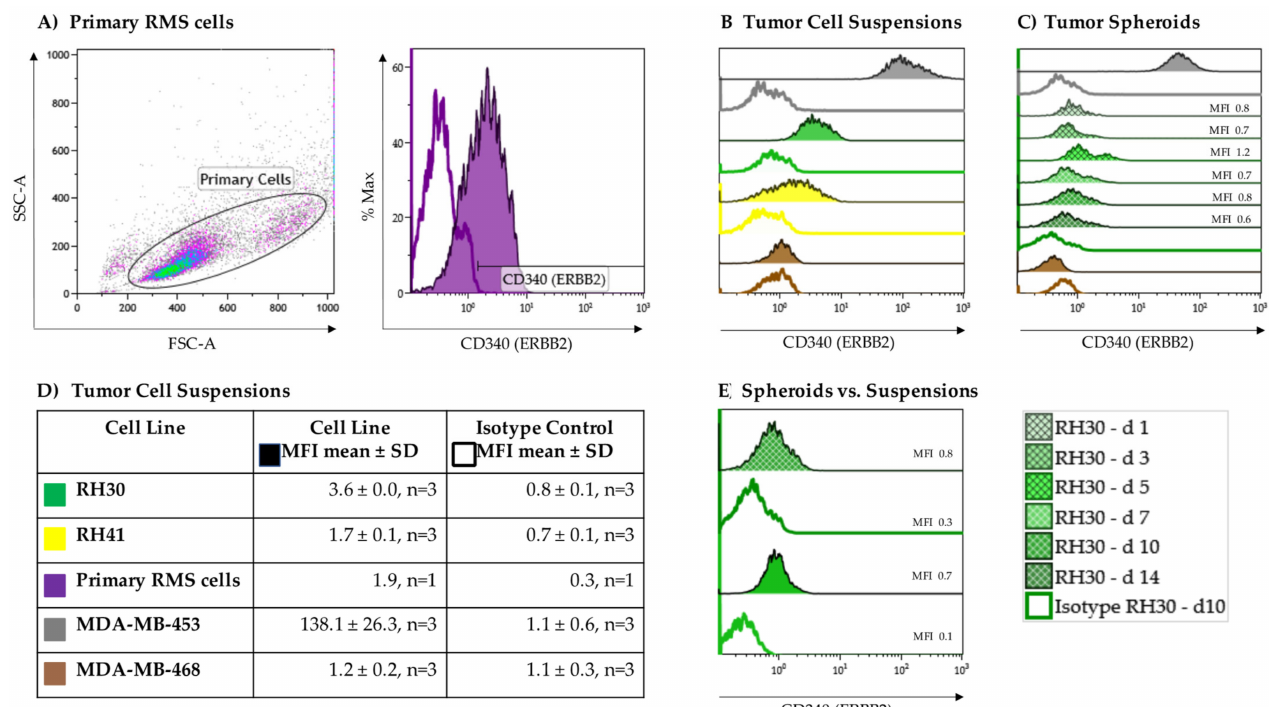
Figure 2. ERBB2 expression on alveolar rhabdomyosarcoma (aRMS) cells. RH30, RH41, and ( A ) primary tumor cell suspensions showed different variability in size (forward (FSC) vs. side scatter (SSC)) and displayed low but homogenous ERBB2 expression compared to isotype controls. The MDA-MB-453 and MDA-MB-468 breast cancer cell lines served as positive and negative controls, respectively ( B , D ). Compared to tumor cell suspensions stable ERBB2 expression was detectable on tumor spheroids during tumor growth ( C , E